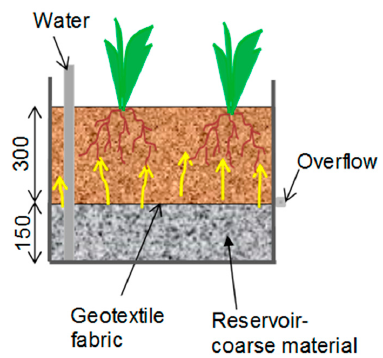
Figure 5. Systematic diagram of a wicking bed.